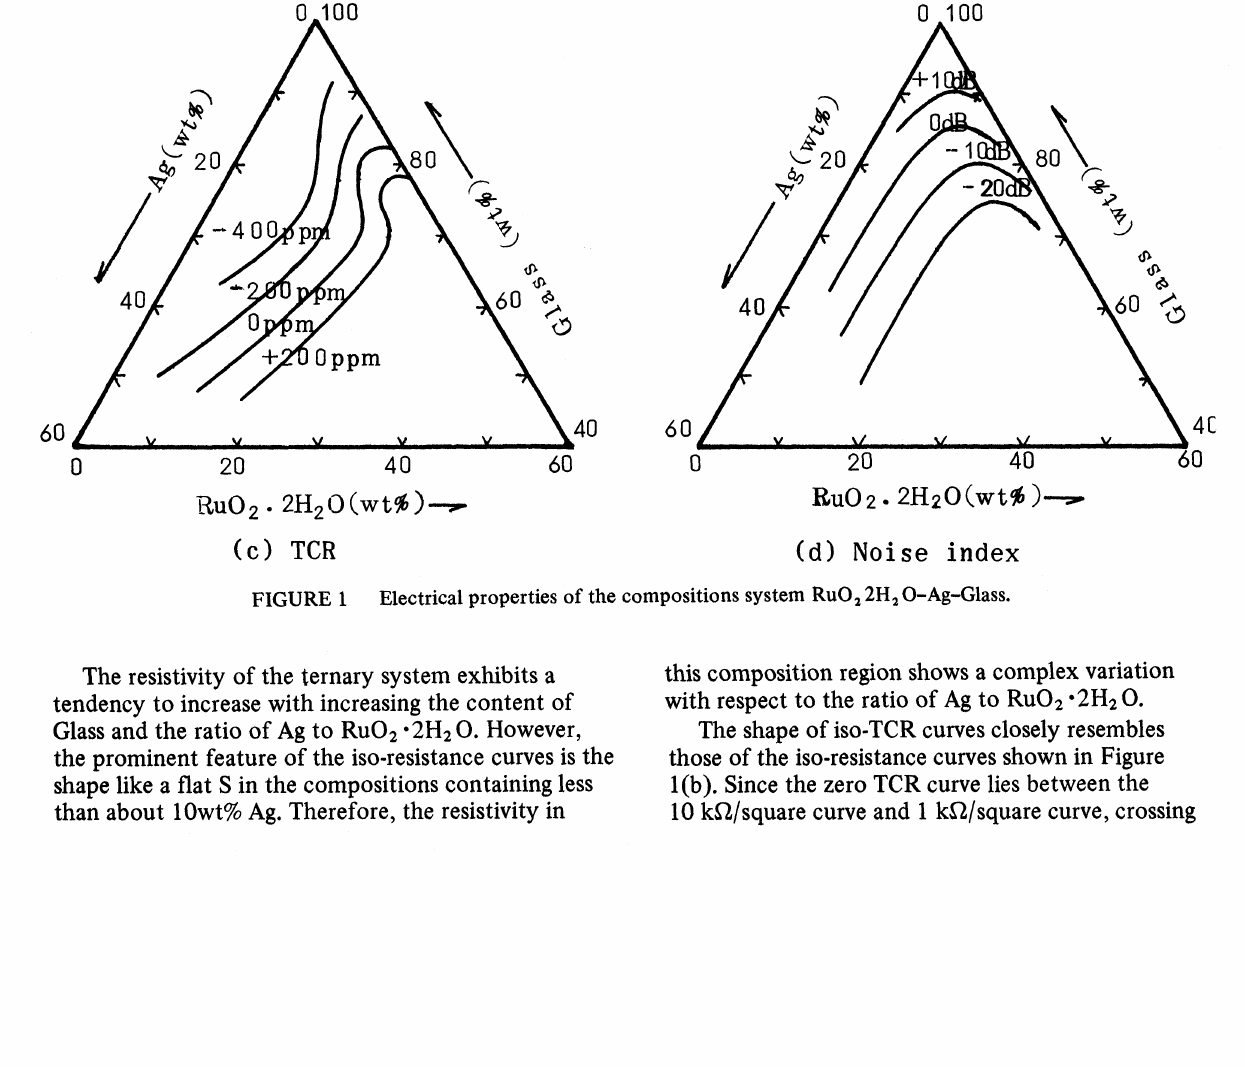
(b). Since the zero TCR curve lies between the 10 k2/square curve and 1 k2/square curve,